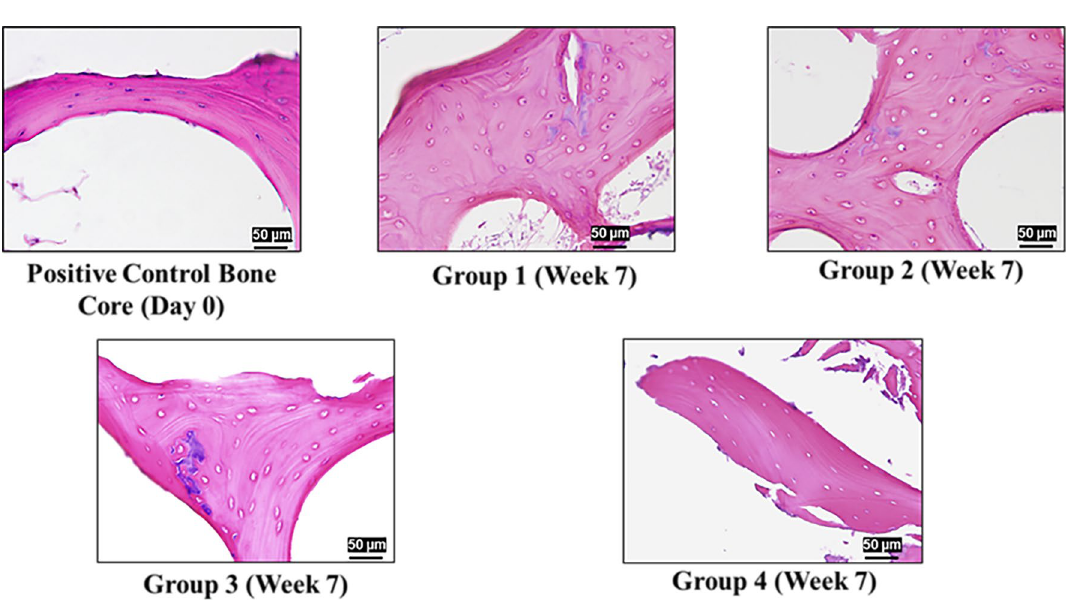
Figure 4. H&E Staining for different groups bone cores at week 7. Group 1) Isolated bone cores placed in static culture, Group 2) Unloaded bone cores placed in static culture in contact with a fiber-mesh metallic scaffold, Group 3) Bone cores placed in contact with a fiber-mesh metallic scaffold under the constant pressure of 150 kPa, Group 4) Bone core placed in contact with a fiber-mesh metallic scaffold and exposed to cyclic loading with continuous perfusion flow of media within the ex-vivo culture system. Cells in group 4 maintained a similar cell structure similar to one in control, while cells in Groups 1–3 changed to a round-like